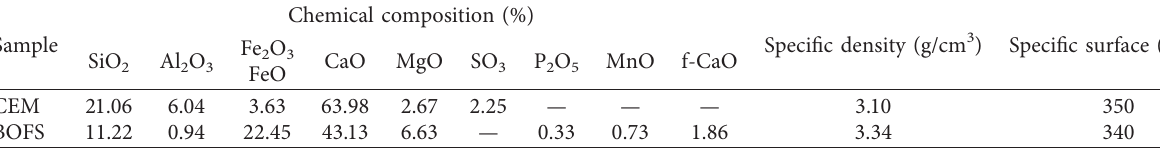
Table 1: Chemical composition and physical properties of cement and BOF slag.